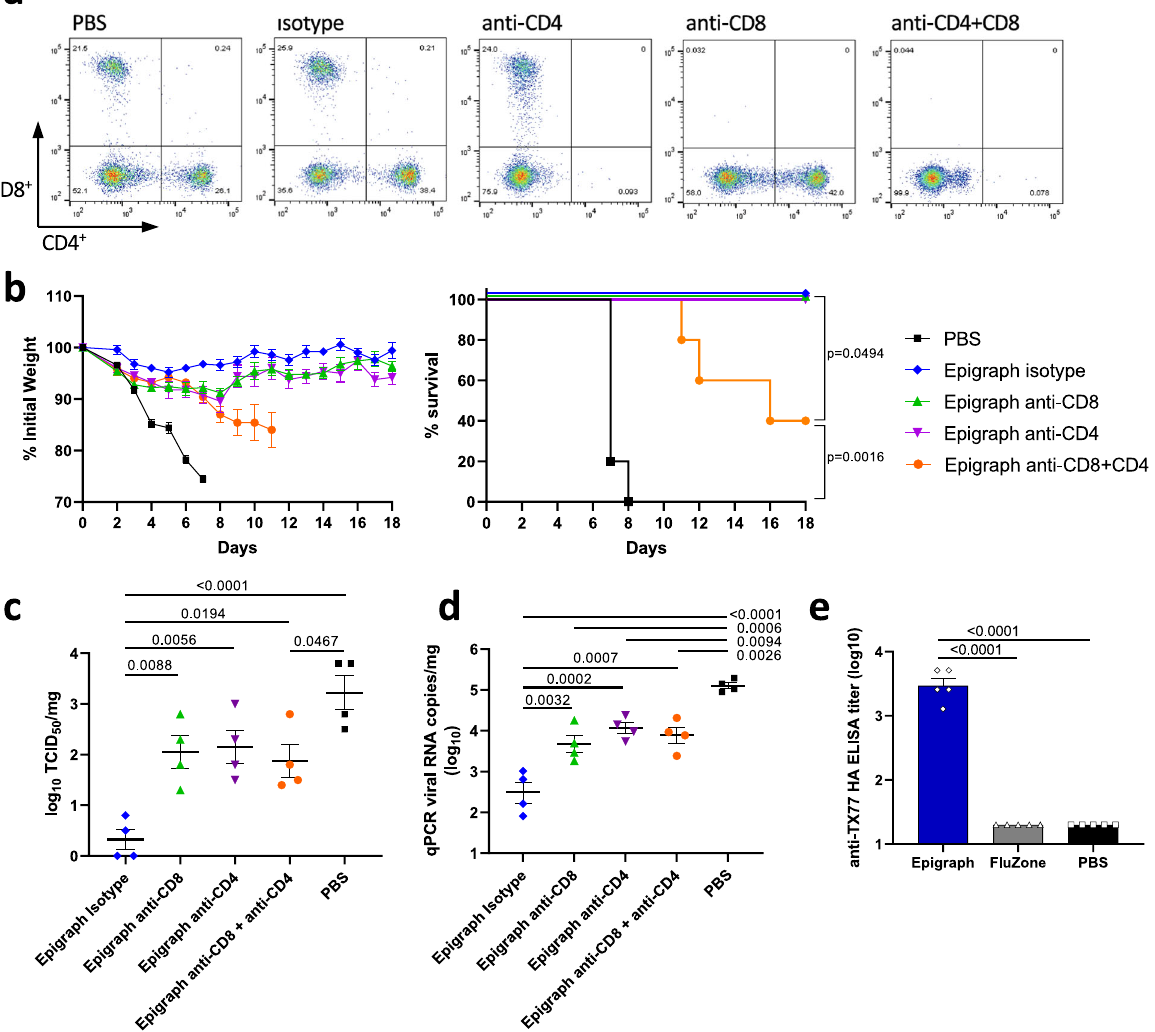
Fig. 5 T-cell depletion during lethal Texas/1977 virus challenge reduces Epigraph vaccine ef fi cacy. BALB/c mice were vaccinated ( n = 9) with 10 10 vp of HAdV-5-Epigraph and depleted for T cells through administration of 200 μ g of anti-mouse CD8, anti-mouse CD4, both anti-CD4 and CD8, or isotype control on day − 3, − 1, and 1 of challenge. a All mice were bled on day 1 post challenge via submandibular vein to con fi rm >98% T-cell depletion by fl ow cytometry. b Mice were challenged intranasally with 10 MLD 50 of Texas/1977 and monitored for weight loss over 18 days. Animals that showed 25% weight loss were humanely euthanized ( n = 5; Kaplan – Meier log-rank test). Weight loss data are censored after the fi rst animal death in a group to prevent survival bias. Three days post infection, four mice per group were sacri fi ced to examine lung viral titers by TCID 50 ( c ) and qPCR ( d ) ( n = 4; one-way ANOVA with Tukey multiple comparison). e An ELISA was performed to examine the presence of binding, non-neutralizing antibodies against Texas/1977 after a single immunization ( n = 5; one-way ANOVA with Tukey multiple comparison). Data are presented as the mean with standard error